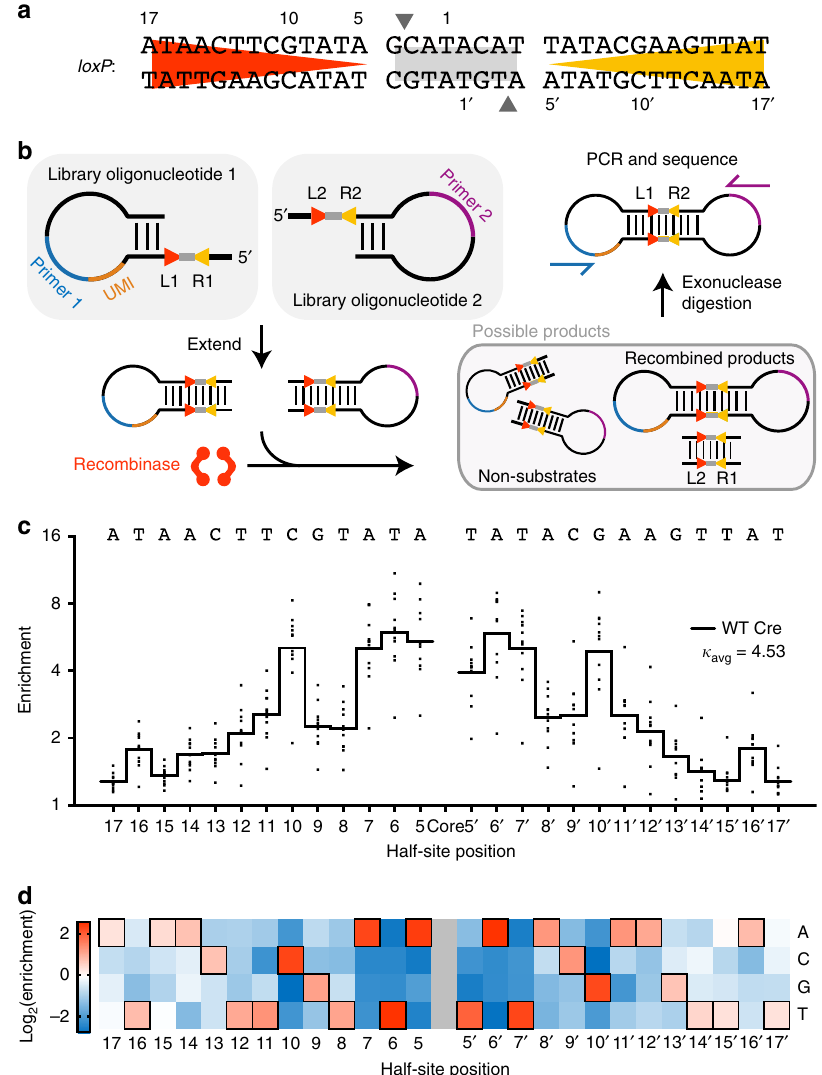
Fig. 1 Recombinase speci fi city pro fi ling of wild-type Cre. a The cognate DNA substrate of Cre, loxP . DNA backbone cleavage occurs at the indicated phosphodiester bond (gray arrows). b Overview of Rec-seq. DNA hairpin oligonucleotides containing partially randomized loxP sites and a unique molecular identi fi er (UMI) are subjected to intramolecular primer extension, exposed to recombinase, and digested with exonucleases to destroy non- recombined DNA. c The speci fi city pro fi le for Cre shows its relative preference for the canonical base at each position in the loxP site. The quality score κ avg represents the number of unique recombination events captured by Rec-Seq across each experimental replicate, with a value over 1.5 considered a well- powered experiment. Values represent the geometric mean of n = 11 independent replicates (dots) conducted at 37 °C for 30 min with a 1:3 ratio of total moles of recombinase:total moles of DNA molecules. d Heat map of Rec-seq enrichment values for wild-type Cre showing the log 2 of the enrichment value for each nucleotide at each position in loxP relative to the canonical base (black outline). Source data are provided as a Source Data fi